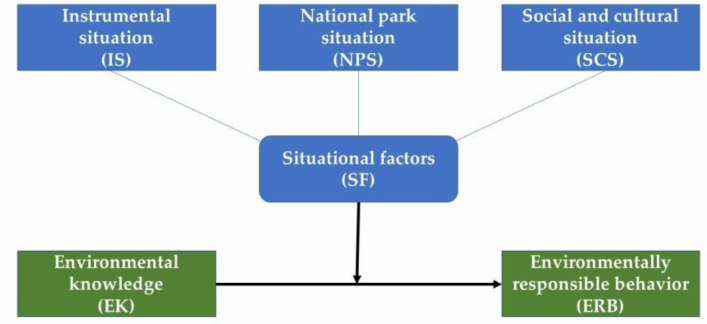
Figure 1. Conceptual research model.